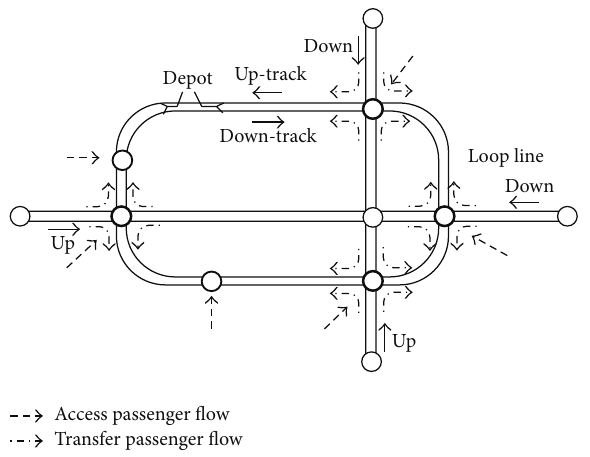
Figure 1: The representation of an urban rail transit loop line.